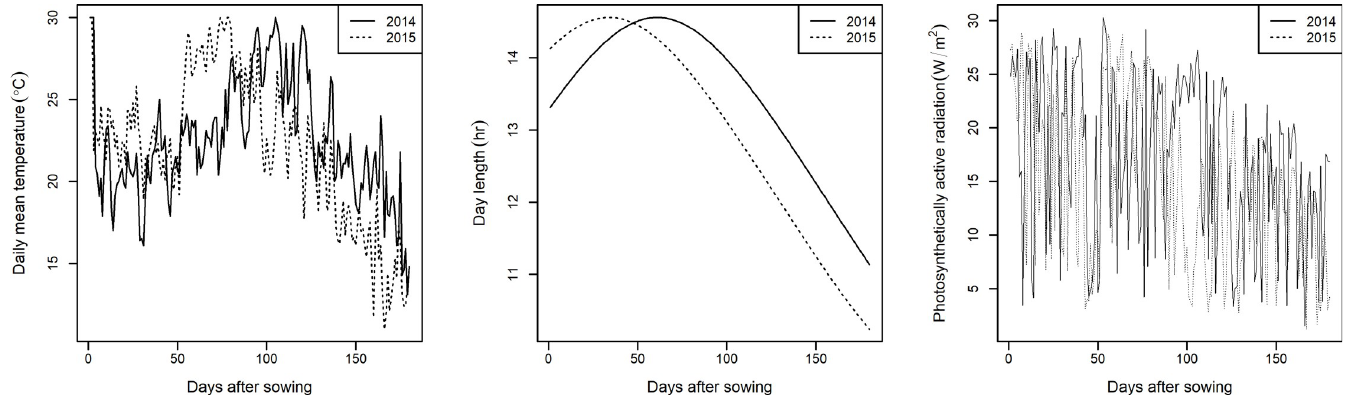
Fig 1. Environmental data during growing season. Daily mean temperature, theoretical day length and photosynthetically active radiation (PAR) of Tsukuba under field trial of RILs are shown. Data in both 2014 and 2015 are expressed as solid and dotted lines, respectively.